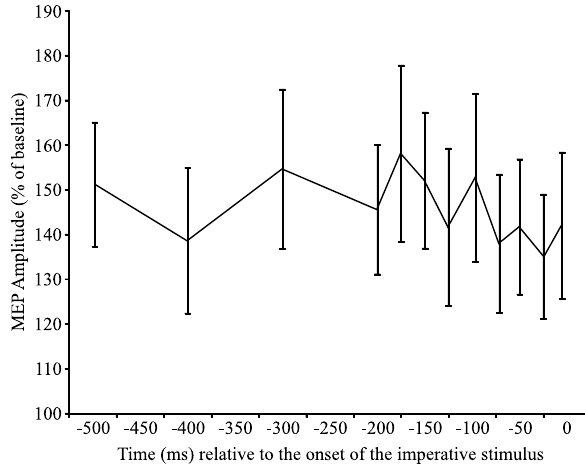
Figure 4. Mean ( + / 2 SE) motor-evoked potential (MEP) amplitude expressed as a percentage of baseline for the time encompassing 2 500 ms to 0 ms relative to the onset of the imperative stimulus. No significant differences in MEP amplitude were found during this time period.